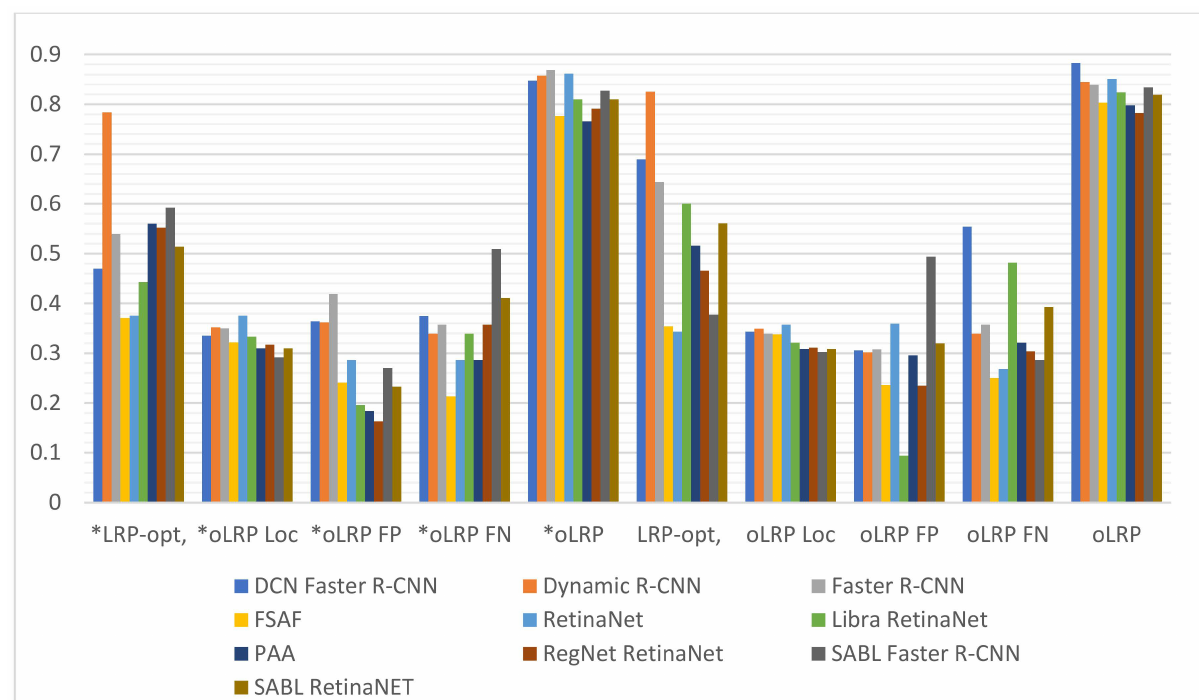
Figure 16. Test LRP-optimal threshold (LRP t ), oLRP Loc (oLRP L ), oLRP FP and oLRP FN results of detection models. (* with